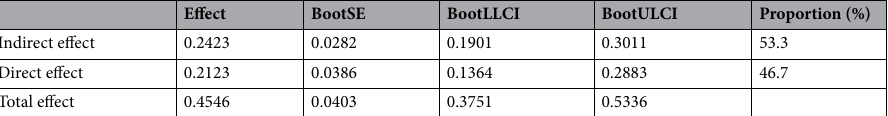
Table 4. Analysis of the mediation function of intrinsic motivation on legal system and pro-environmental